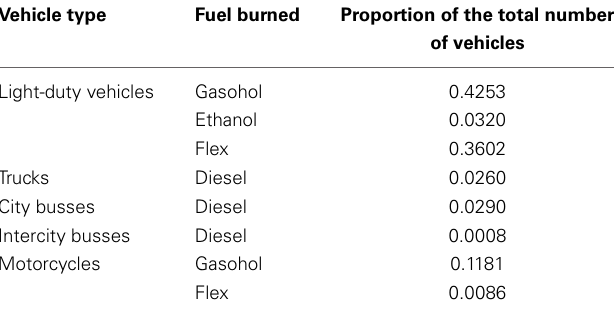
FIGURE 4 | Emission factors for CO, NO x , SO 2 , and particles for different vehicle type/fuel combinations. LD-G, light-duty vehicles